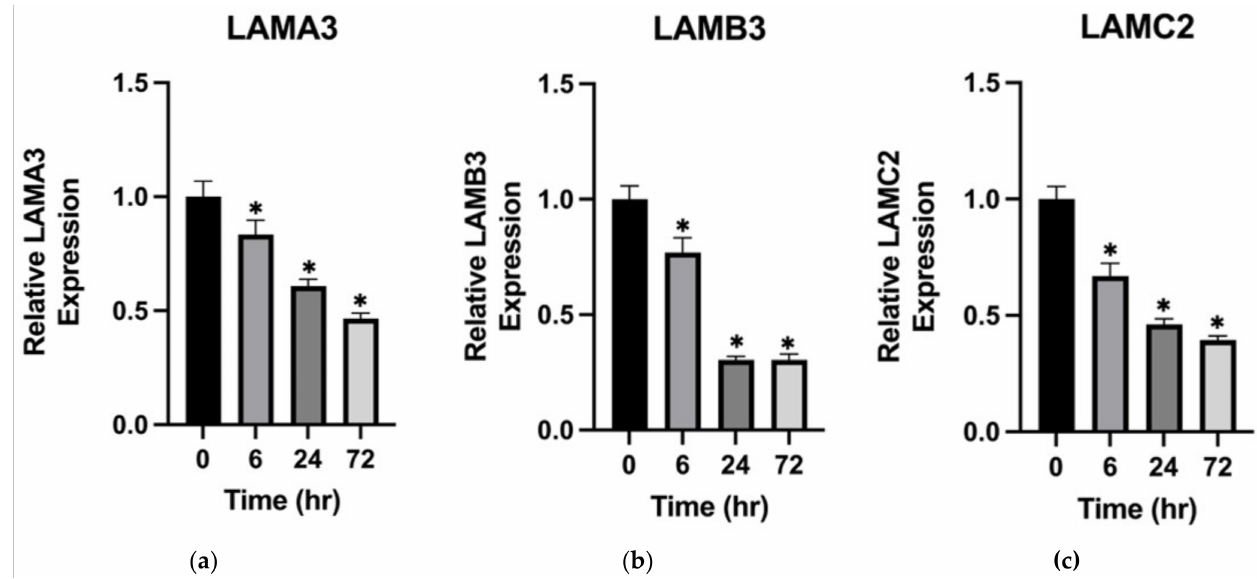
Figure 4. Vildagliptin decreased the expression of LAMA3 , LAMB3 , and LAMC2 in a time-dependent manner. HaCaT was treated with Vildagliptin (5 µ M) for 0, 6, 24, and 72 h. The expression of ( a ) LAMA3 , ( b ) LAMB3 , and (c) LAMC2 was checked by qPCR. * [ p <